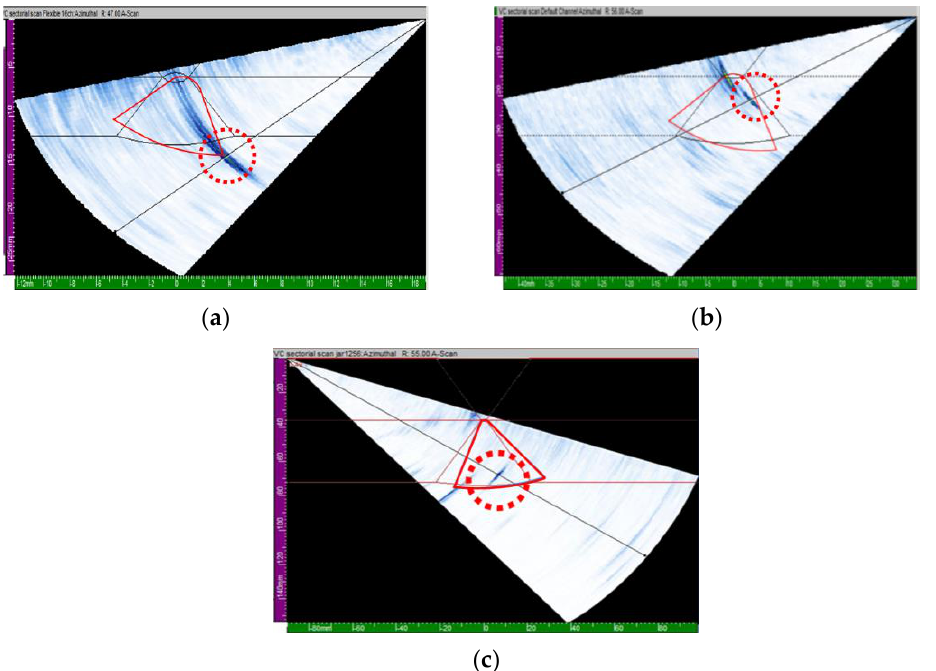
Figure 19. S-scan image results of flaws detected by the FPAPr on the pipe specimens: ( a ) flange–elbow weld zone surface notch flaw image; ( b ) tapered elbow weld interior LoF flaw image; ( c ) upper-tapered weld upper notch flaw image.